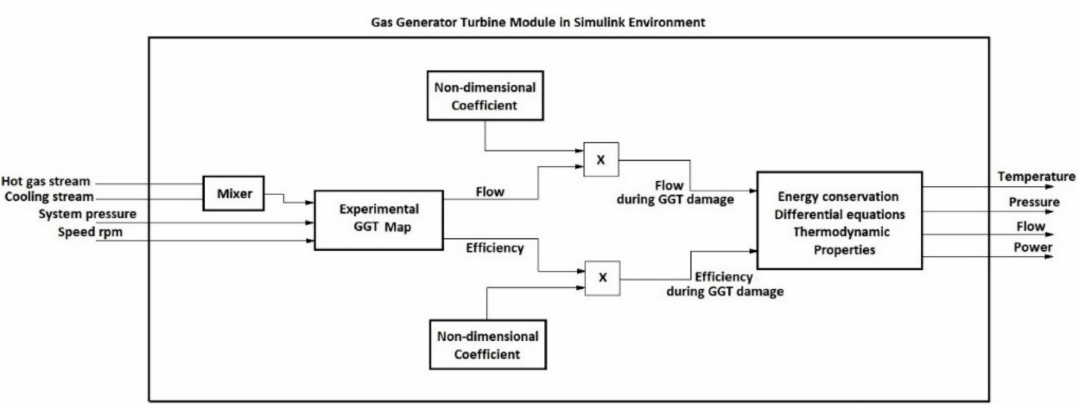
Figure 17. Implementation of non-dimensional coefficients in the gas generator